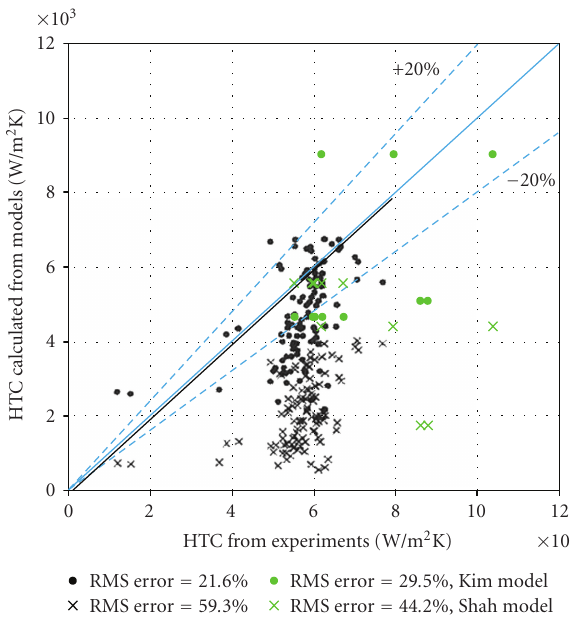
Figure 21: Comparison between PERSEO facility data (green) and Kim’s data